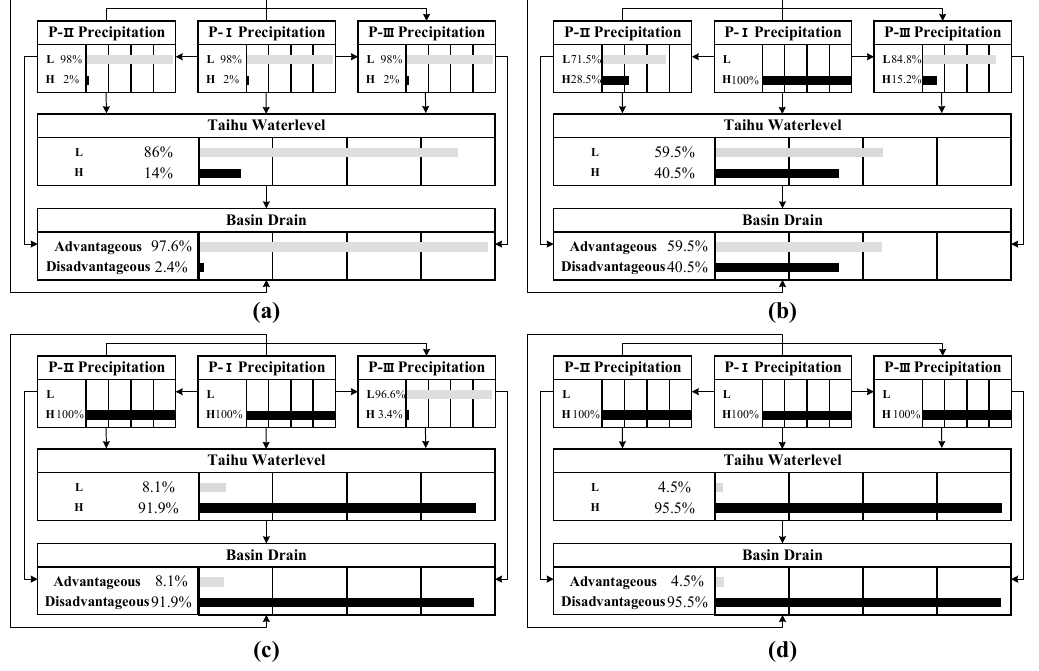
Figure 11. The priori reasoning of Bayesian network ( a ), and the posterior probability of various precipitation situations ( b – d ) in the plum rain period.